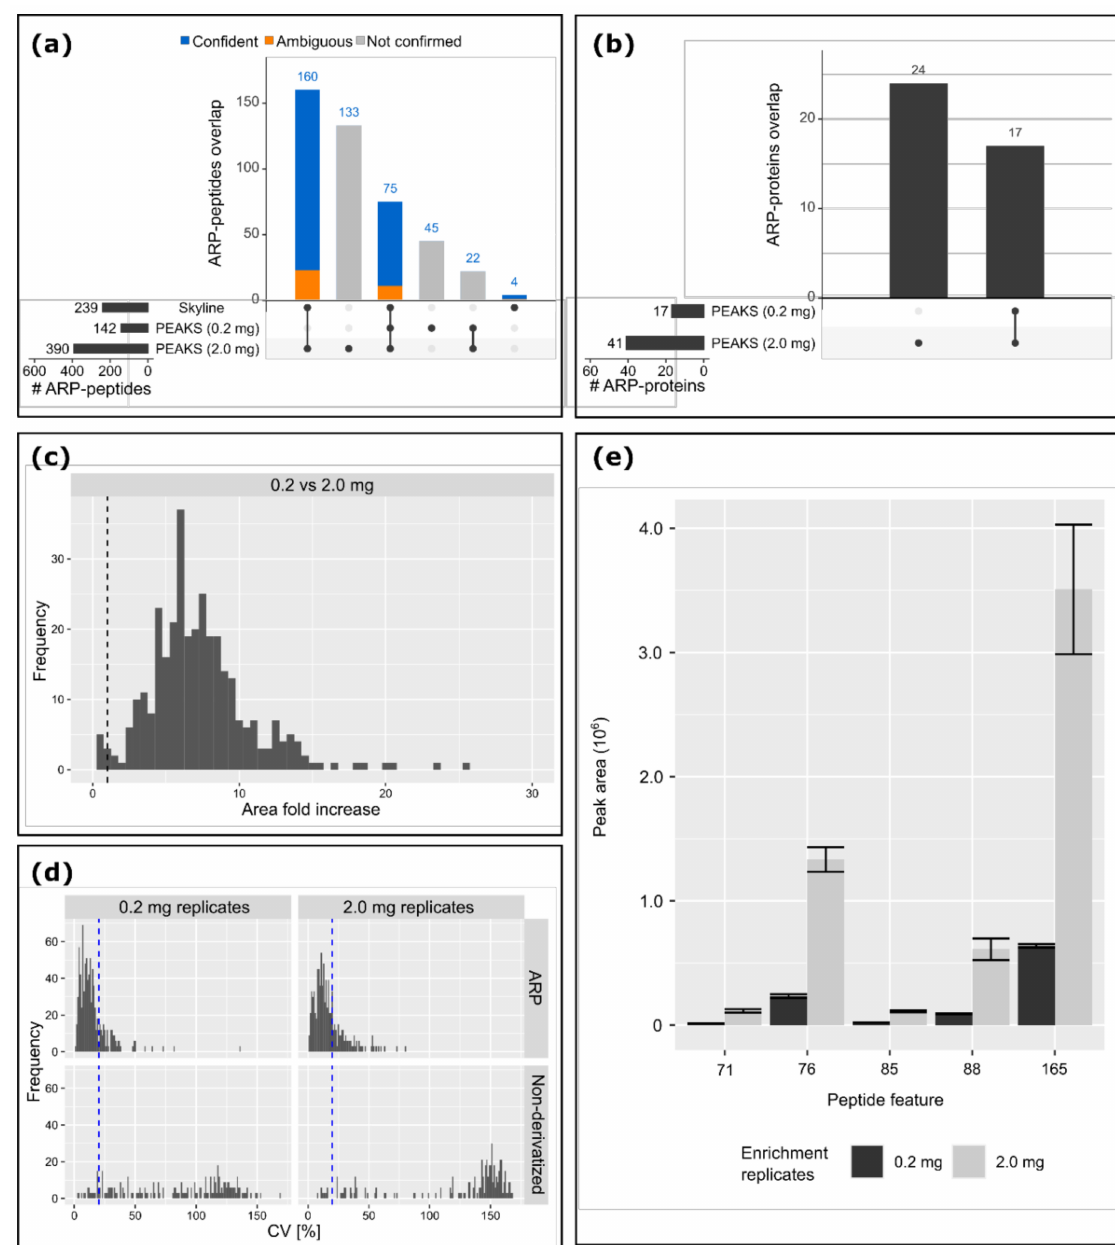
Figure 4. Identification and quantitation of ARP peptides in tryptic plasma digests starting with low and high protein quantities of 0.2 mg and 2 mg plasma protein, respectively. ( a ) UpSet plot of ARP peptides proposed by PEAKS (5% false discovery rate (FDR), peptide level) and after validation by Skyline. The total number of peptides per classification are displayed in horizontal bars and overlapping identifications in vertical bars. The confidence level is indicated by color, i.e., blue, orange, and gray indicating confident, ambiguous, and unconfirmed sequences, respectively. ( b ) UpSet plot of proteins confidently identified by Skyline on the basis of all confidently validated ARP peptides. ( c ) Increase of peak areas obtained for confidently identified ARP peptides when upscaling the analytics from low to high plasma protein quantities. ( d ) Coefficients of variation (CV) for ARP peptides (top) and non-derivatized peptides (bottom). ( e ) Peak areas of HSA peptide LKC[+57.021]ASLQK modified on the second residue (Lys199 in HSA) by mass shifts of +475.174 Da (71), +355.131 Da (76), +385.142 Da (85), +369.147 Da (88), and +312.089 Da